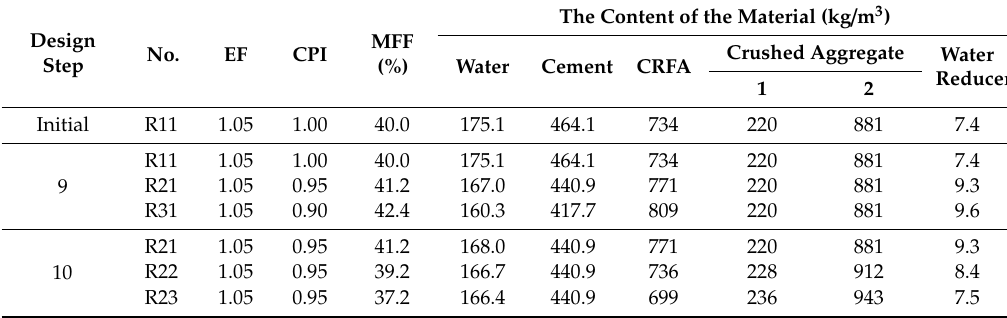
Table 7. The mixture proportions of the concrete samples.